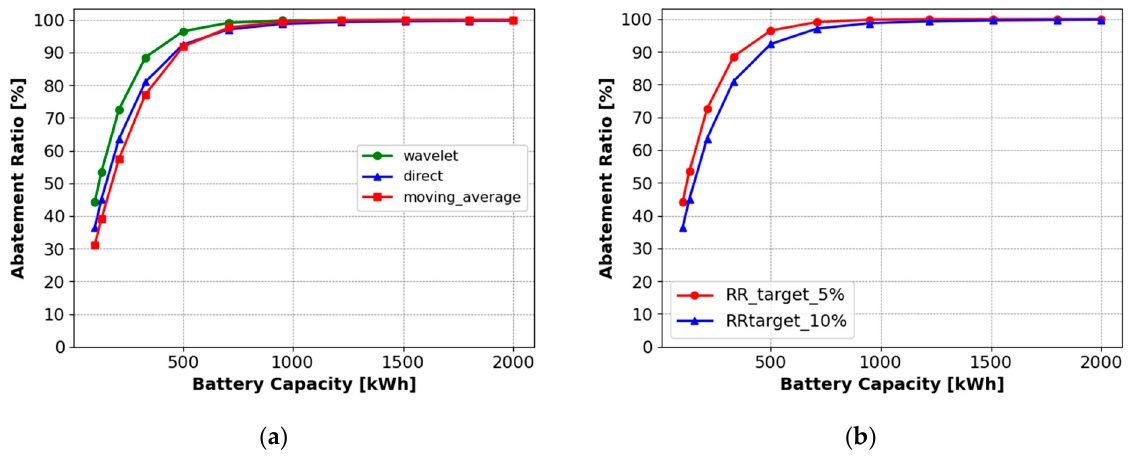
Figure 24. Ramp rate (RR) target 5%: ( a ) AR vs. Battery Capacity ( b ) RR target comparison: 5% vs. 10%.